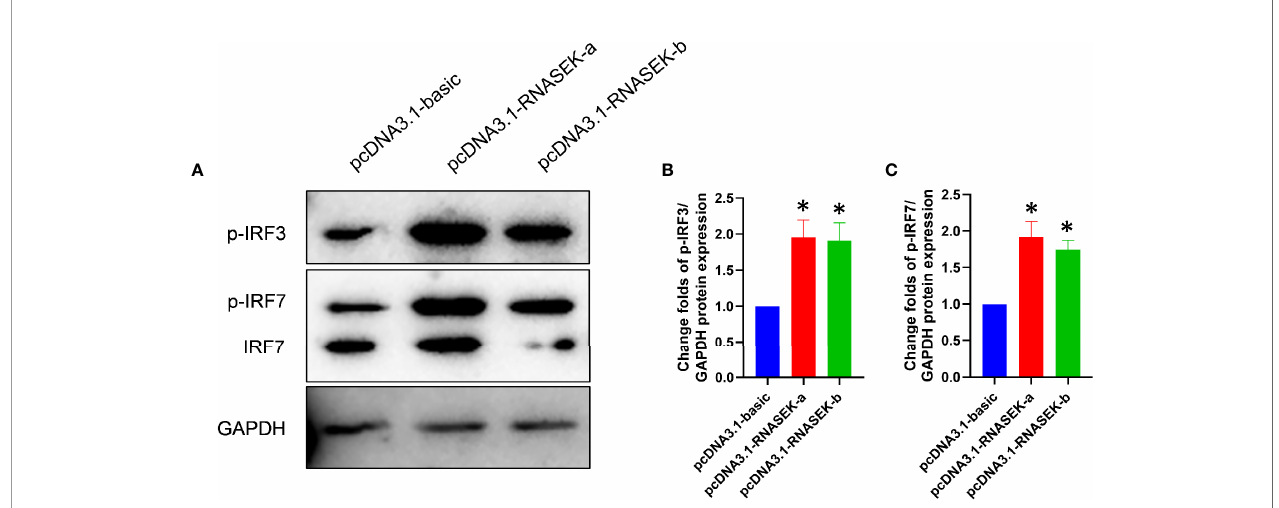
FIGURE 4 | Grass carp RNASEK-a and -b individually activate IRF3 and IRF7. (A) In CIK cells, the protein levels of p-IRF3, p-IRF7, and IRF7 were tested by using Western blot with GAPDH as a loading control. (B, C) The grayscale values of p-IRF3 and p-IRF7 bands representing (A) were individually calculated by the ImageJ software ( n = 3 – 5; the control data were normalized to 1). Overexpression of RNASEK-a and -b was conducted by transfection of pcDNA3.1-RNASEK-a and -RNASEK-b into CIK cells for 36 h, respectively. All values are mean ± SD. These results are representative of three independent experiments. * P < 0.05 versus the pcDNA3.1-basic